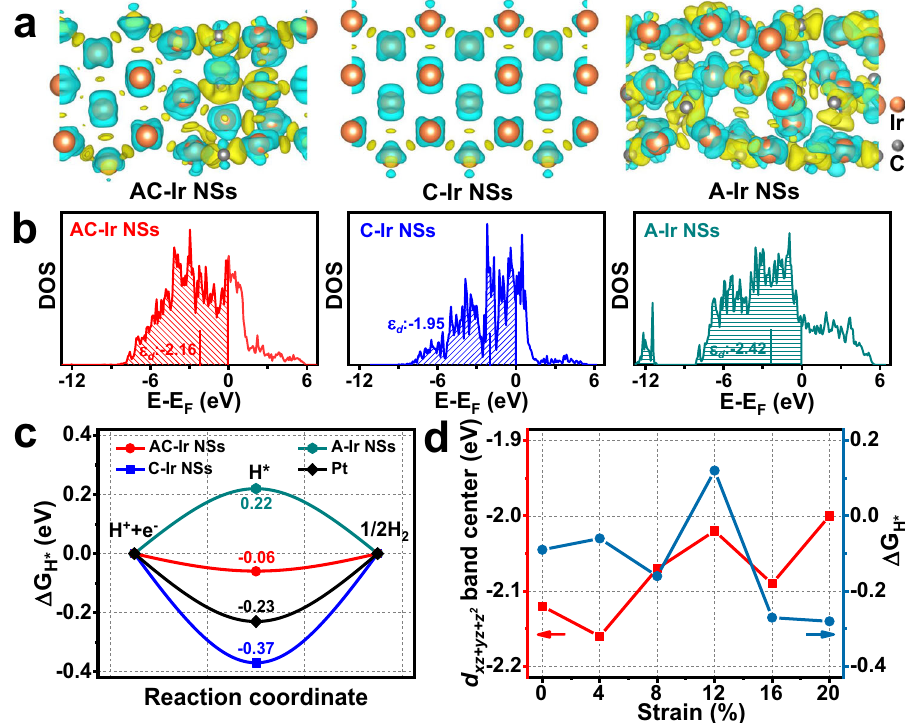
Fig. 5 Understanding the effect of tensile strain. a The deformation charge density analysis of AC-Ir NSs with 4% tensile strain, C-Ir NSs and A-Ir NSs, respectively (isosurface is 0.12 bohr − 3 , cyan represent charge depletion and yellow represent charge accumulation.). b The d xz + yz + z 2 band centers of the active Ir sites for AC-Ir NSs with 4% tensile strain, C-Ir NSs and A-Ir NSs, respectively. Note: ɛ d refers to E d xz + yz + z 2 . c The calculated Δ G H* on AC-Ir NSs with 4% tensile strain, C-Ir NSs and A-Ir NSs respectively. d The d xz + yz + z 2 band centers of the active Ir sites and the calculated Δ G H* on AC-Ir NSs with different degrees of lattice